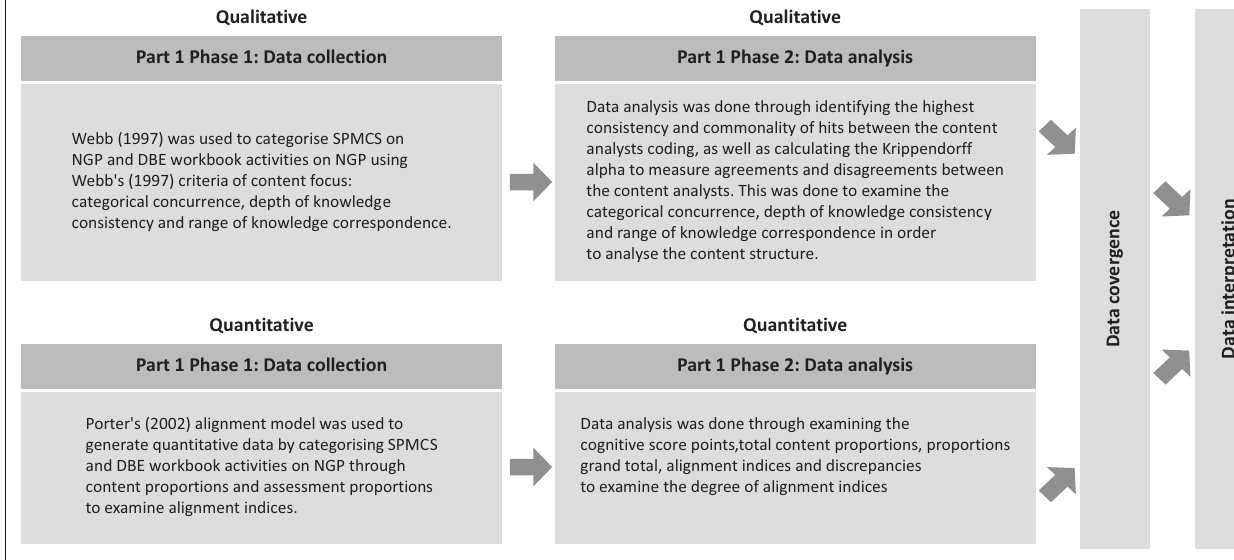
FIGURE 1. Concurrent triangulation